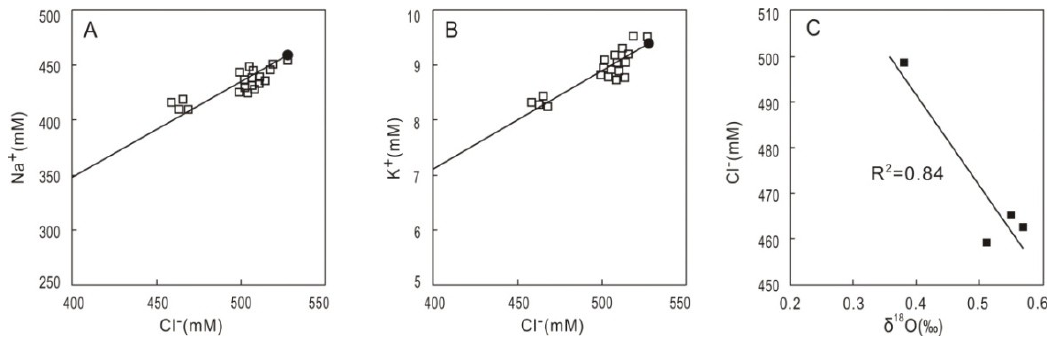
Figure 4. Plots of Cl − vs. Na + ( A ), K + ( B ), and δ 18 O ( C ). Solid circles in ( A ) and ( B ) indicate seawater